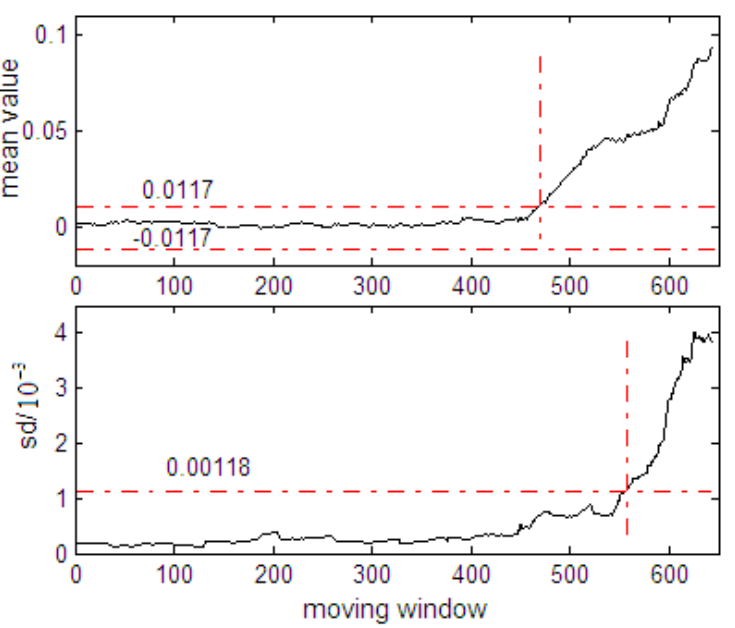
Figure 11. Statistical characteristics for Case